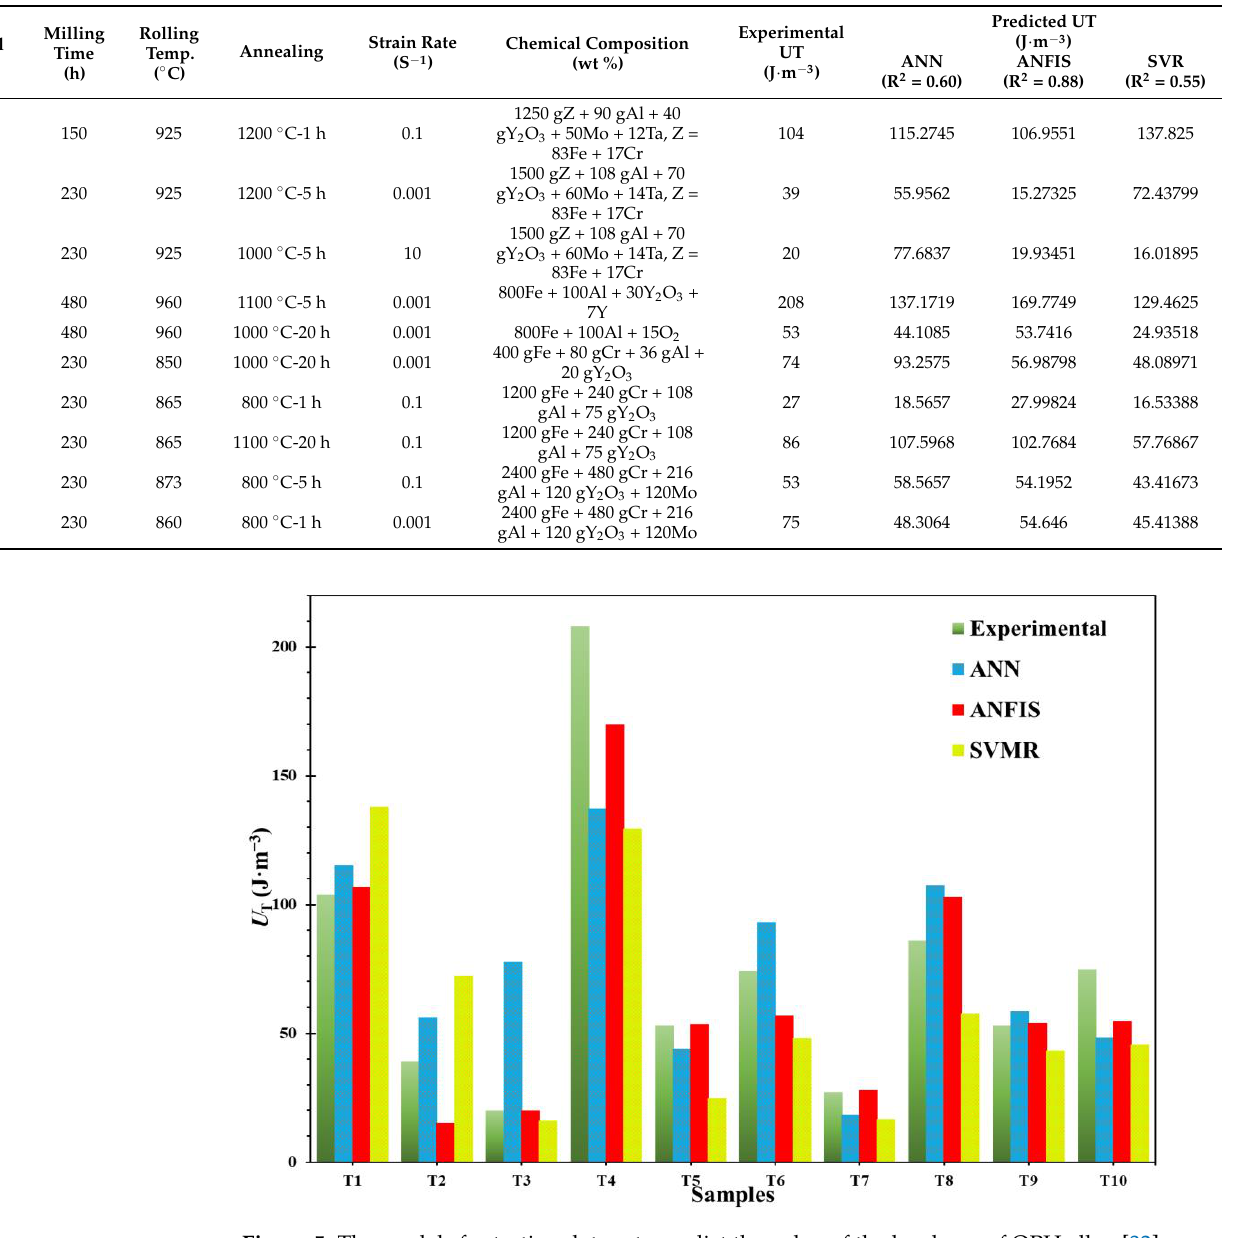
Figure 5. The models for testing data sets predict the value of the hardness of OPH alloy [32]. Table 5. The material parameters of the samples for testing the models with the prediction results.